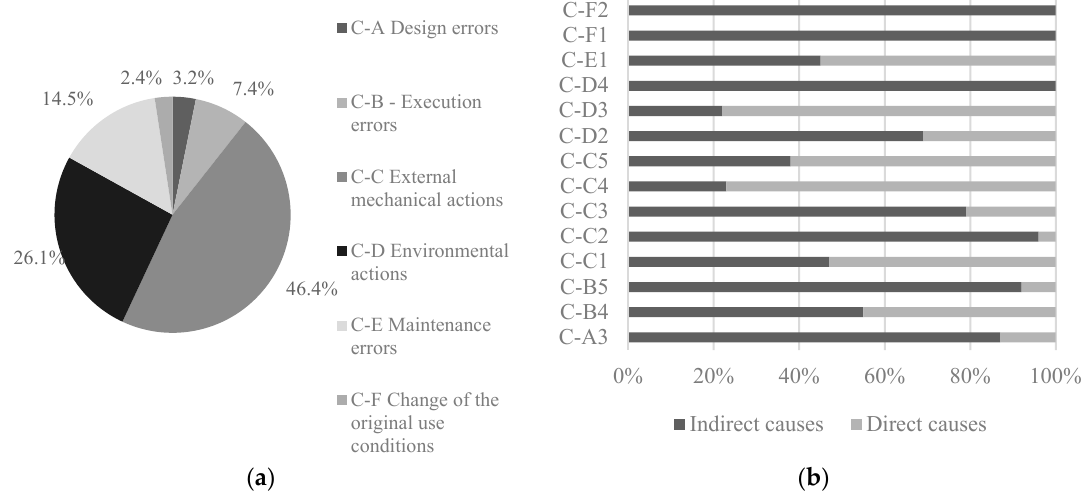
Figure 6. Probable causes of anomalies: ( a ) Relative frequency of each group of causes; and ( b ) direct vs. indirect causes.